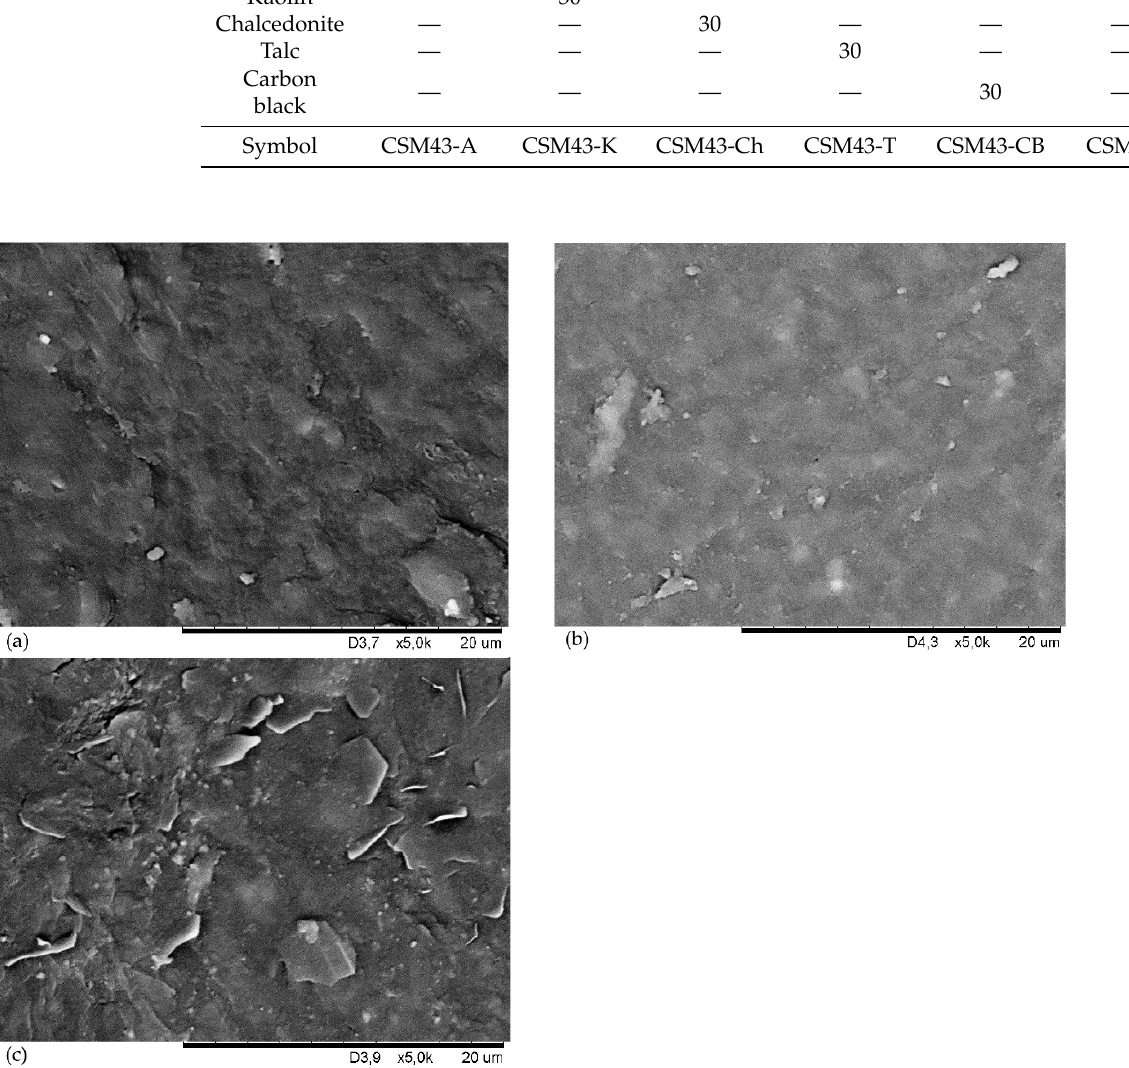
Table 5. The formulations of the composites used in the second series of tests.